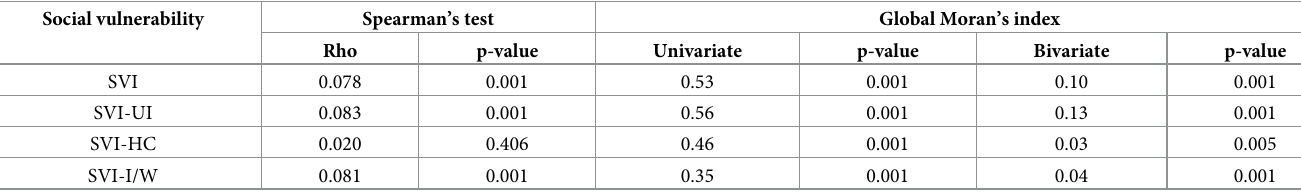
Table 6. Association between VL transmission and social vulnerability in Northeast region of Brazil.